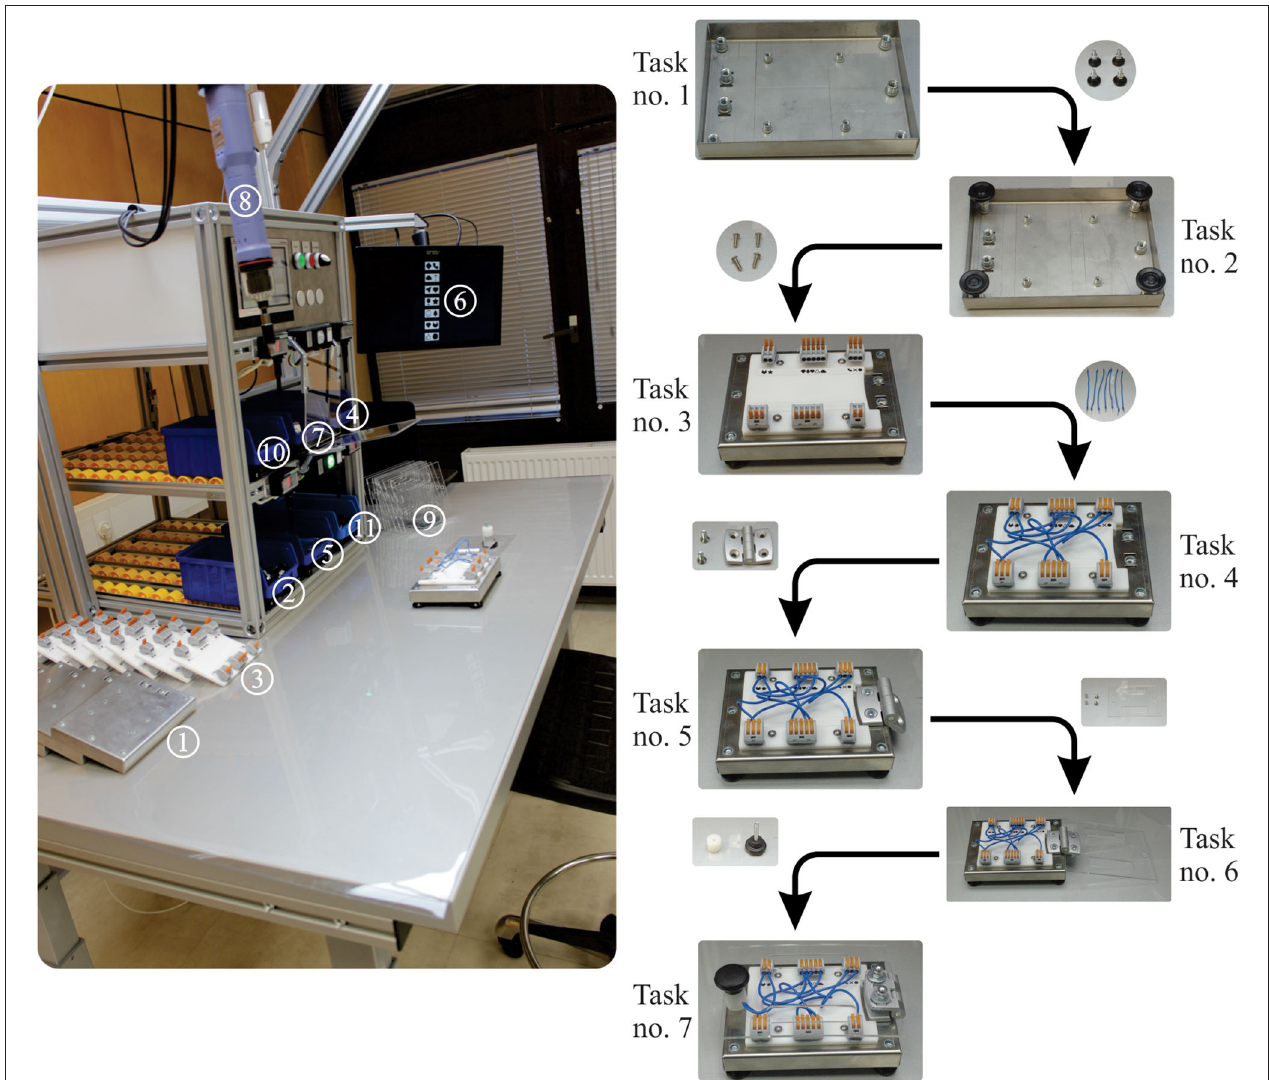
FIGURE 6 | Description of the experimental